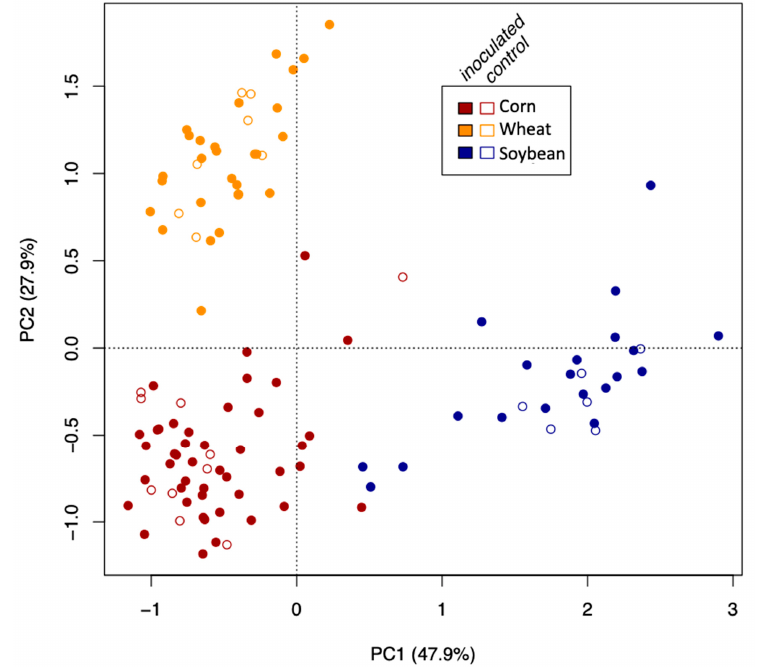
Figure 5. The effect of crop species on the AMF community structure based on principle coordinate analysis (PCoA) of the square root transformed for all the soil samples. Color coding is used to distinguish the three crop plant species (wheat, corn, and soybean) and open and filled circles for the inoculated and non-inoculated treatments. Microorganisms 2020 , 8 , 83 RDA analysis was conducted with all three environmental variables (crop species * growth stage * treatment). Given that inoculation did not show a significant effect ( p -value = 0.3), we conducted the RDA without this factor removing the term from the model. Both the model ( p -value = 0.001), the first three axes ( p -value = 0.001, p -value = 0.001, and p -value = 0.006, respectively), the crop species ( p -value = 0.001), and the growth stage ( p -value = 0.006) were significant. We identified several taxa that seem characteristic for one of the three crop species and for growth stage (Figure 6), such as VTX00113 ( R. irregularis ) and VTX00062 ( Diversispora sp. , Figure 2) that were characteristic for early corn growth stage or VTX00115 ( Glomus sp . synonym Rhizophagus sp. MO − G13, in Figure 2) and VTX00067 ( Glomus mosseaea , synonym Funneliformis mosseaea ) which were abundant under wheat cropping.